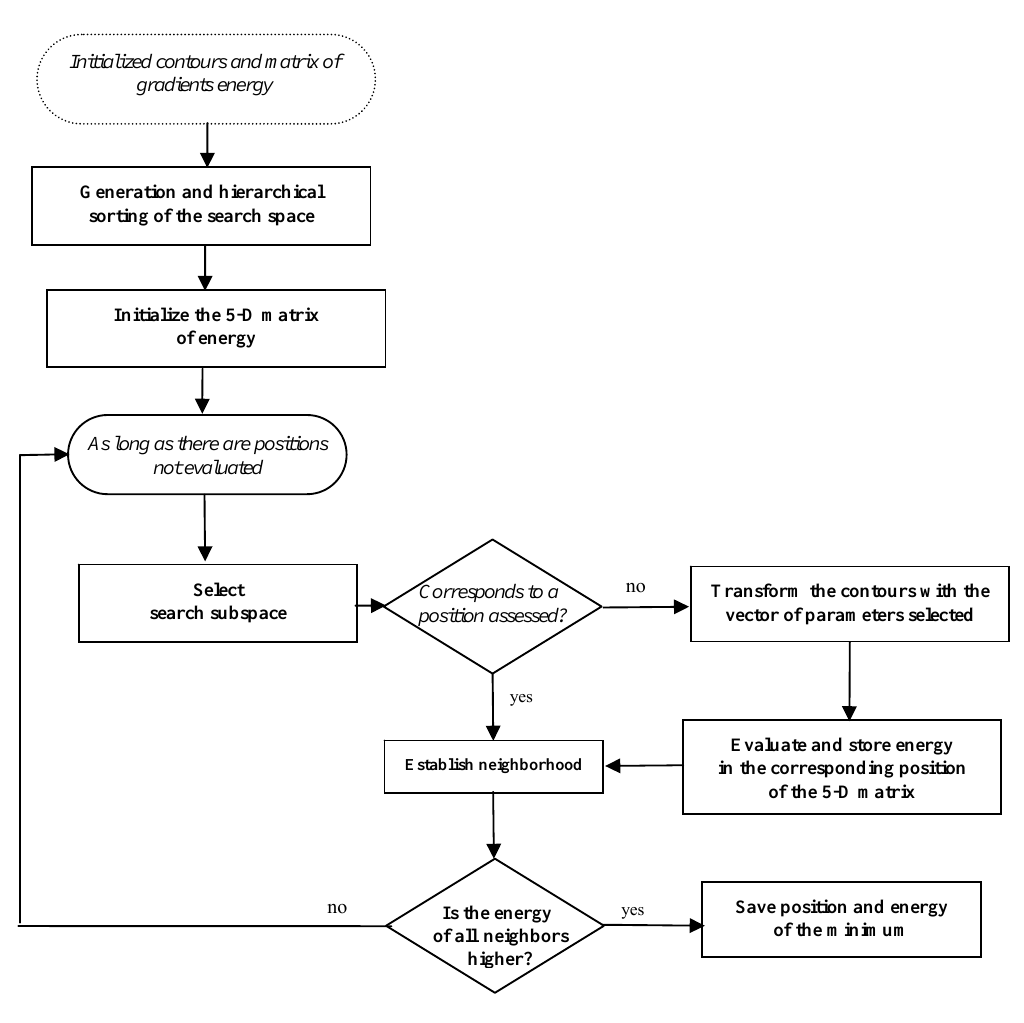
Figure 4. Flowchart of the exhaustive search